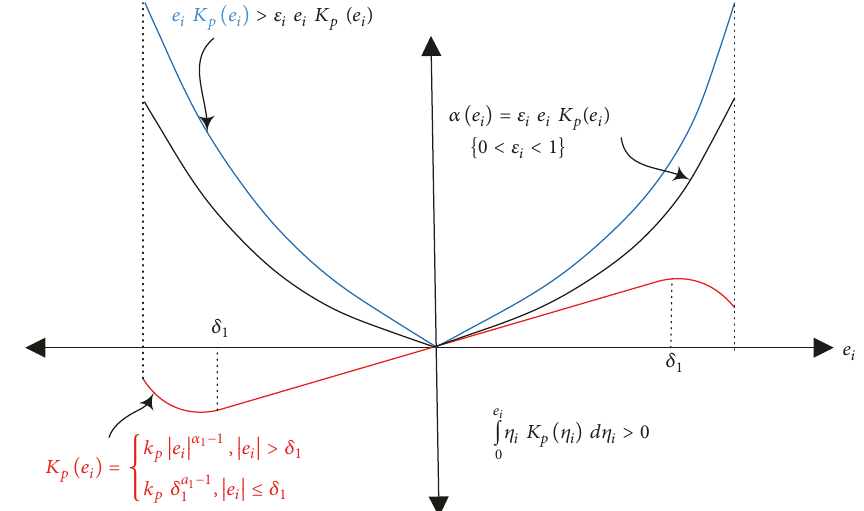
Figure 6: Graphical description of Lemma